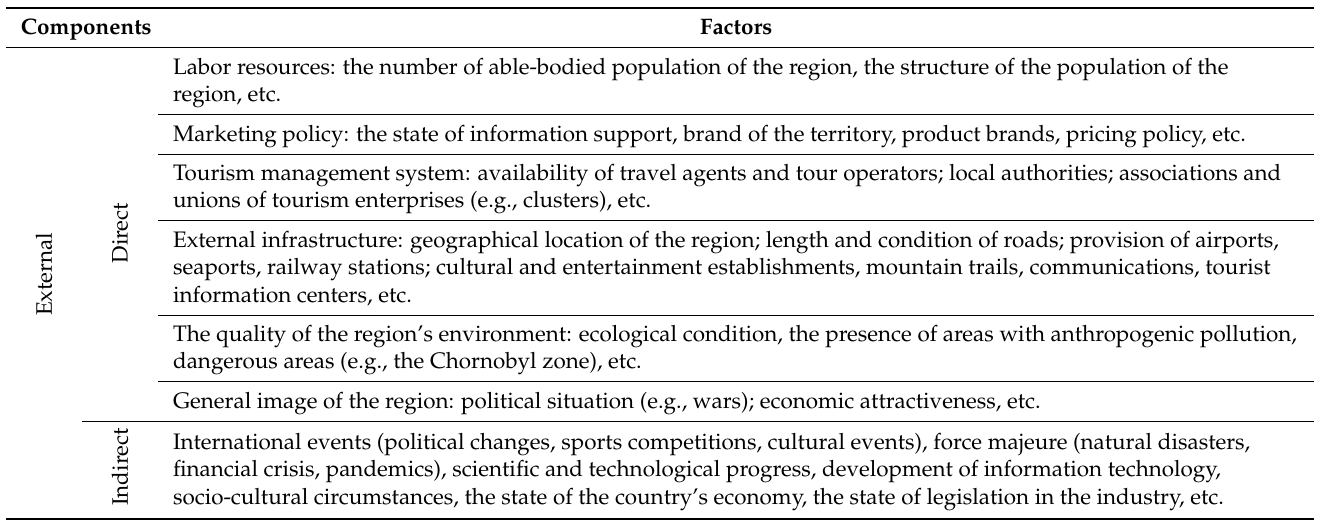
Table 1. The system of components and factors affecting the level of use of the regional tourism potential. Components Factors Labor resources: the number of able-bodied population of the region, the structure of the population of the region,